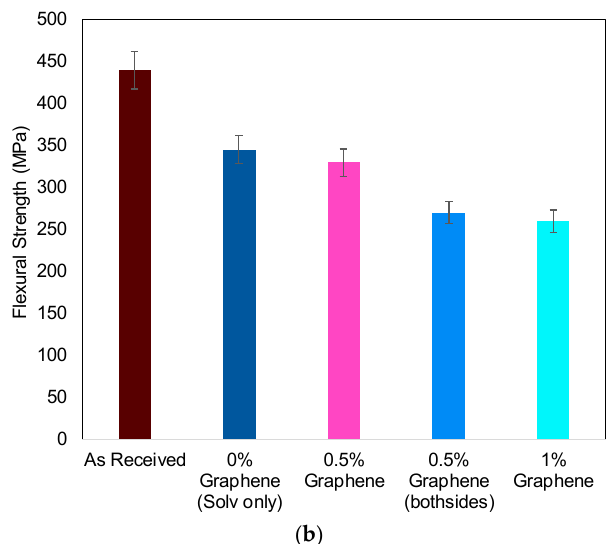
Figure 12. Flexural properties of different percentages of graphene coated glass fiber composites ( a ) flexural Modulus; ( b ) flexural Strength.